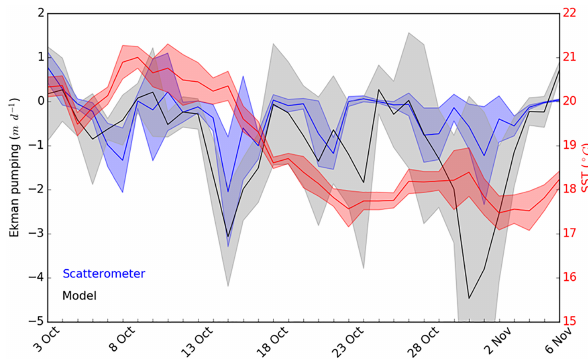
Figure 10. Ekman pumping vertical velocities (in md − 1 ) computed from scatterometer (in blue) and atmospheric model (in black) wind speeds and mean SST (in red, in ◦ C) in our study area from 3 Oc- tober to 6 November. Shade areas represent the SD relative to each measurement. Negative Ekman pumping values represent upward vertical